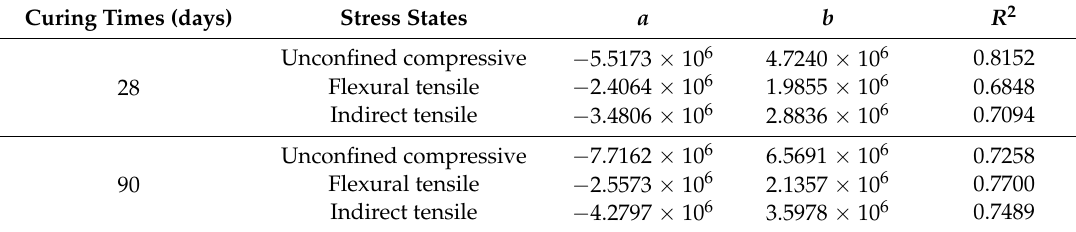
Table 7. Fitting parameters for the fatigue equation with a cement content of 5% under different stress